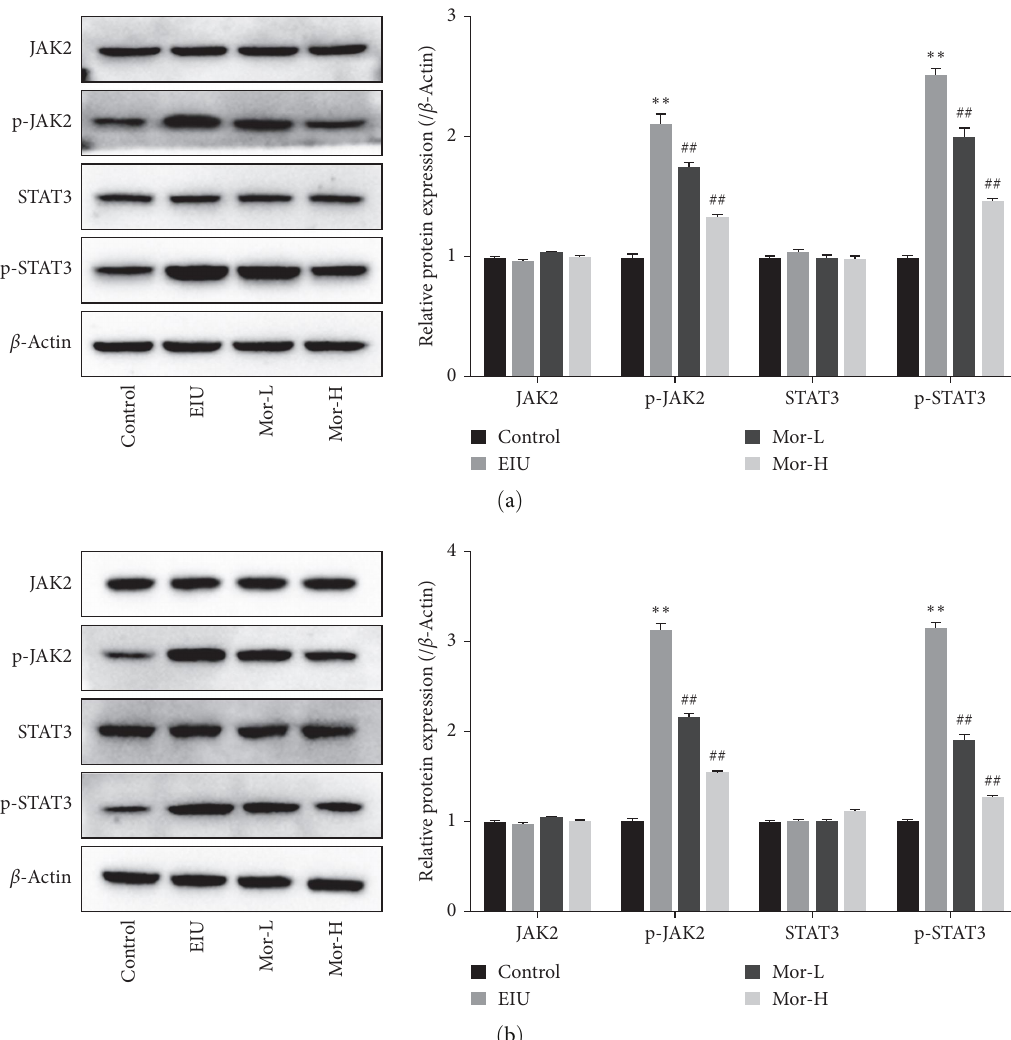
F IGURE 4: Effect of morroniside on the JAK/STAT signaling pathway in EIU mice. (a) JAK2, p-JAK2, STAT3, and p-STAT3 protein expression in ciliary body tissues. (b) JAK2, p-JAK2, STAT3, and p-STAT3 protein expression in retinal tissues. Means Æ SD from three independent samples are shown. The data in western blot assays were expressed after normalization to β -actin expression. Comparison with the control group: ∗∗ P < 0 : 01. Comparison with the EIU group: ## P < 0 :